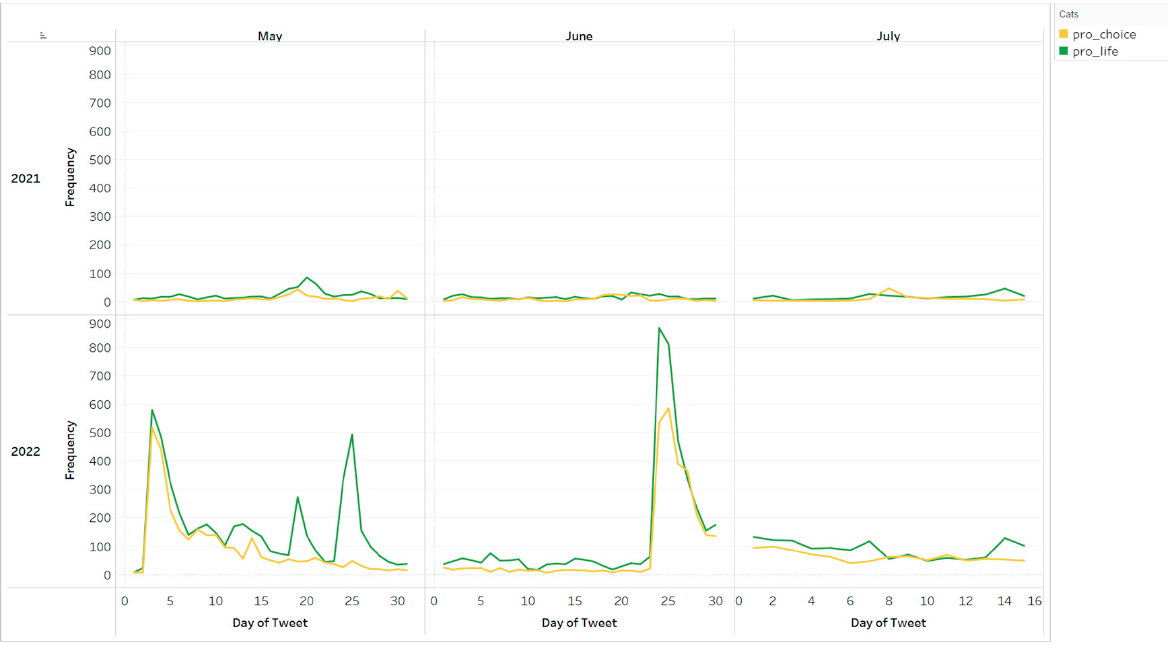
Figure A3. Number of pro-choice and pro-life tweets across 1 May–15 July 2021 and 2022.